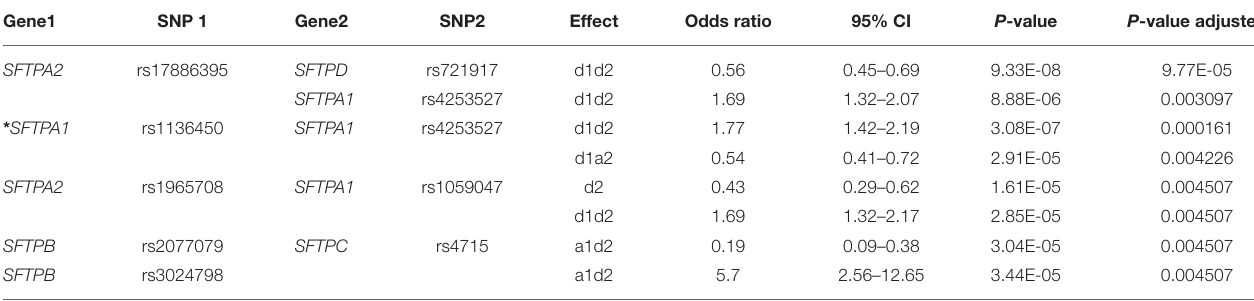
TABLE 3 | The two SNP interactions associated with RDS